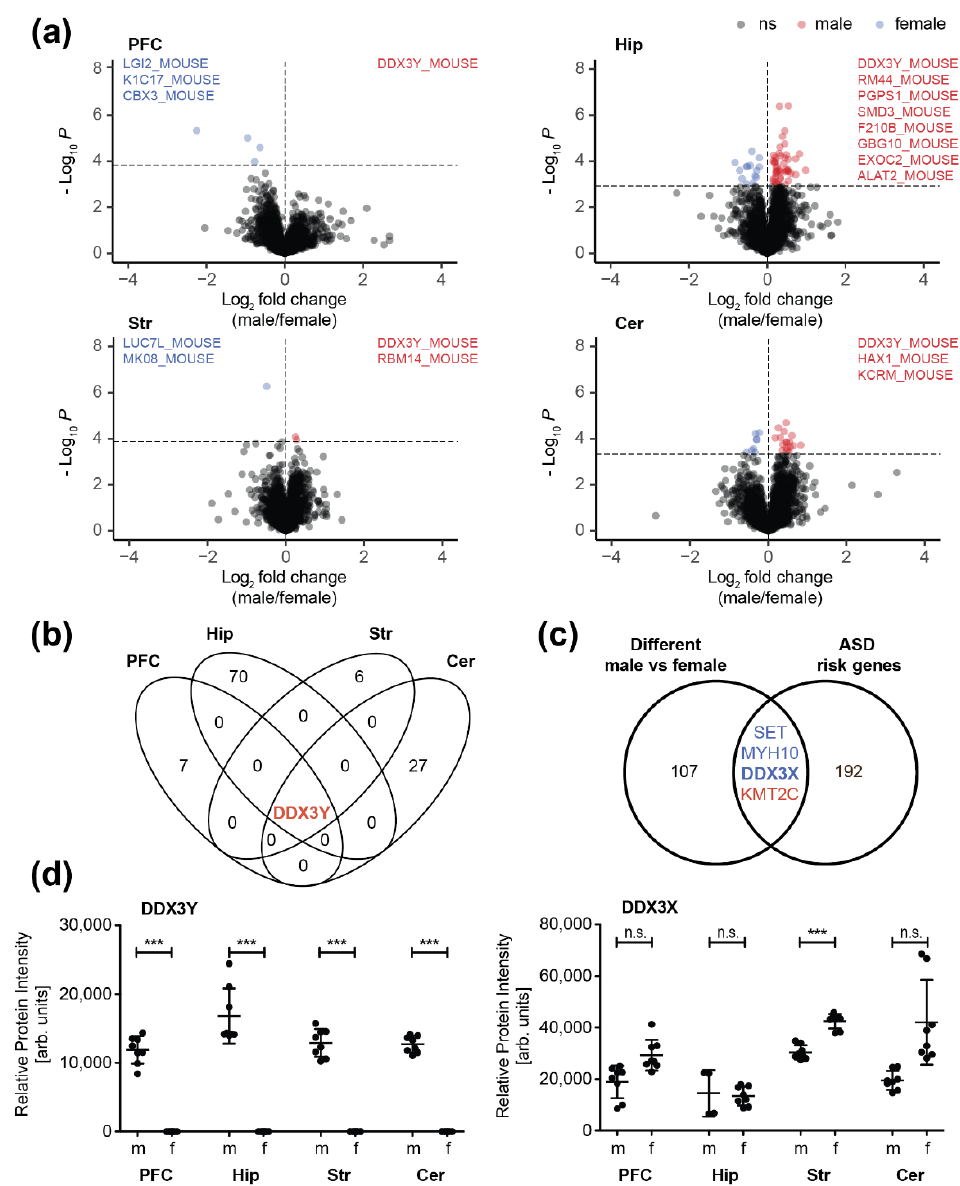
Figure 3. Sex-related differences in synaptic proteome composition: ( a ) Volcano plots displaying differentially regulated synaptic proteins of the prefrontal cortex (PFC), hippocampus (Hip), striatum (Str), and cerebellum (Cer) between male (m) and female (f) mice. Significantly regulated proteins (BH corrected Student´s t -test, p < 0.05) are highlighted blue (female) and red (male). Uniprot entries listed in the plots mark proteins, exclusively detected either in male (blue) or female mice (red). ( b ) Overlap of significantly regulated proteins (male versus female) in different brain regions. ( c ) Overlap of all differently expressed proteins between male and female mice with autism spectrum disorder (ASD) risk genes (see Supplementary Figure S9 and Supplementary Table S4); ( d ) Relative protein levels of DDX3Y and DDX3X. Asterisks (***) indicate highly significant differences in protein abundances between the two sexes ( p < 0.001, Student´s t -test). n.s., not significant.